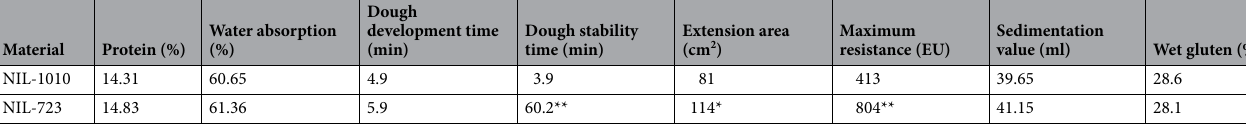
Table 1. Quality measurement index of NIL-723 and NIL-1010. *, **Represents significant difference at P < 0.05 and P < 0.01,